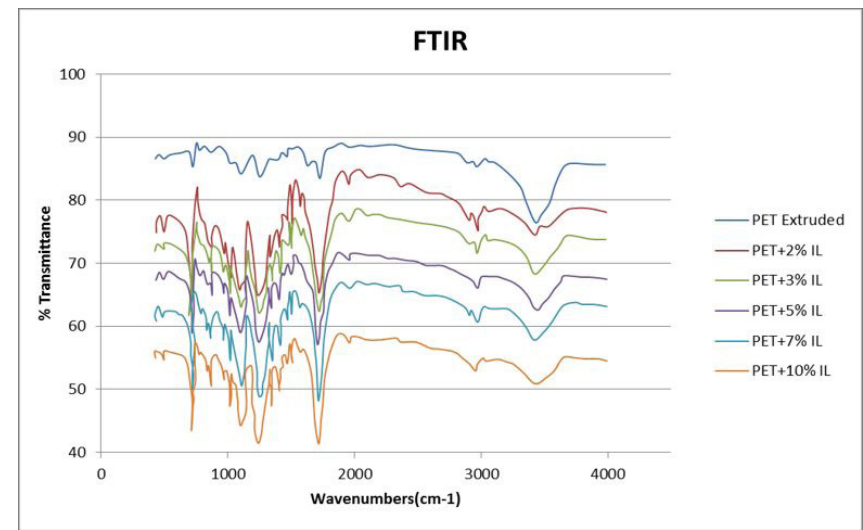
Figure 10. FTIR spectroscopy for neat PET and all prepared PET-IL